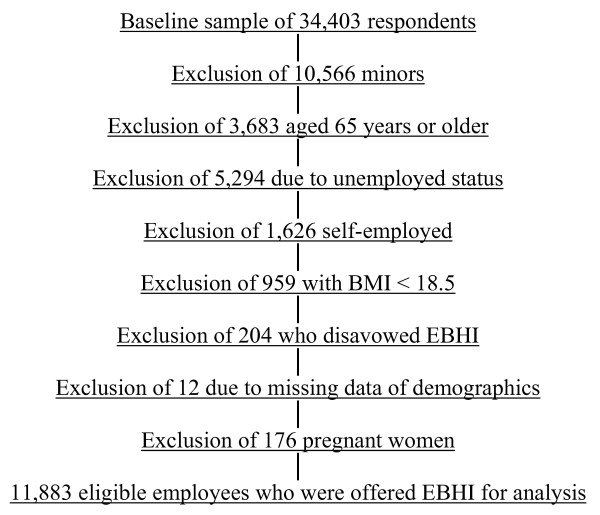
Selection criteria for inclusion in full model analysis.